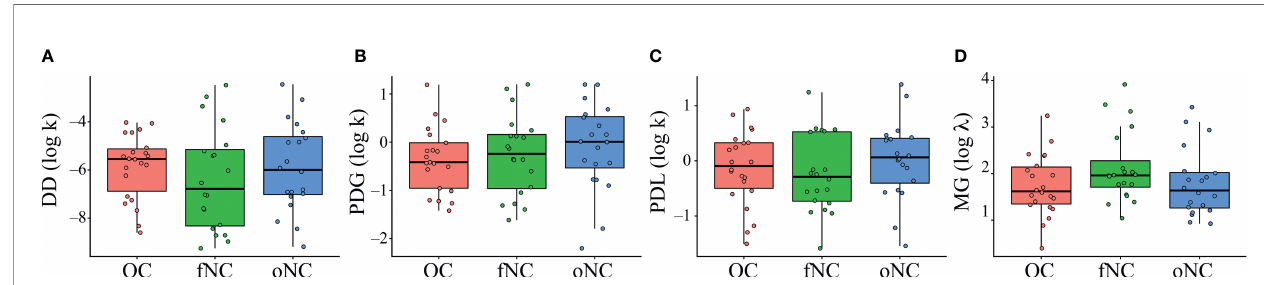
FIGURE 2 | Boxplots showing outcomes for the parameter k of the (A) delay discounting (DD), (B) probability discounting for gains (PDG), and (C) probability discounting for losses (PDL) tasks, and l of the (D) mixed gambles (MG) task. Each dot represents an individual subject. OC, women using OCs; fNC, women in the early follicular phase; oNC, women during periovulatory phase. Whiskers indicate variability outside the upper and